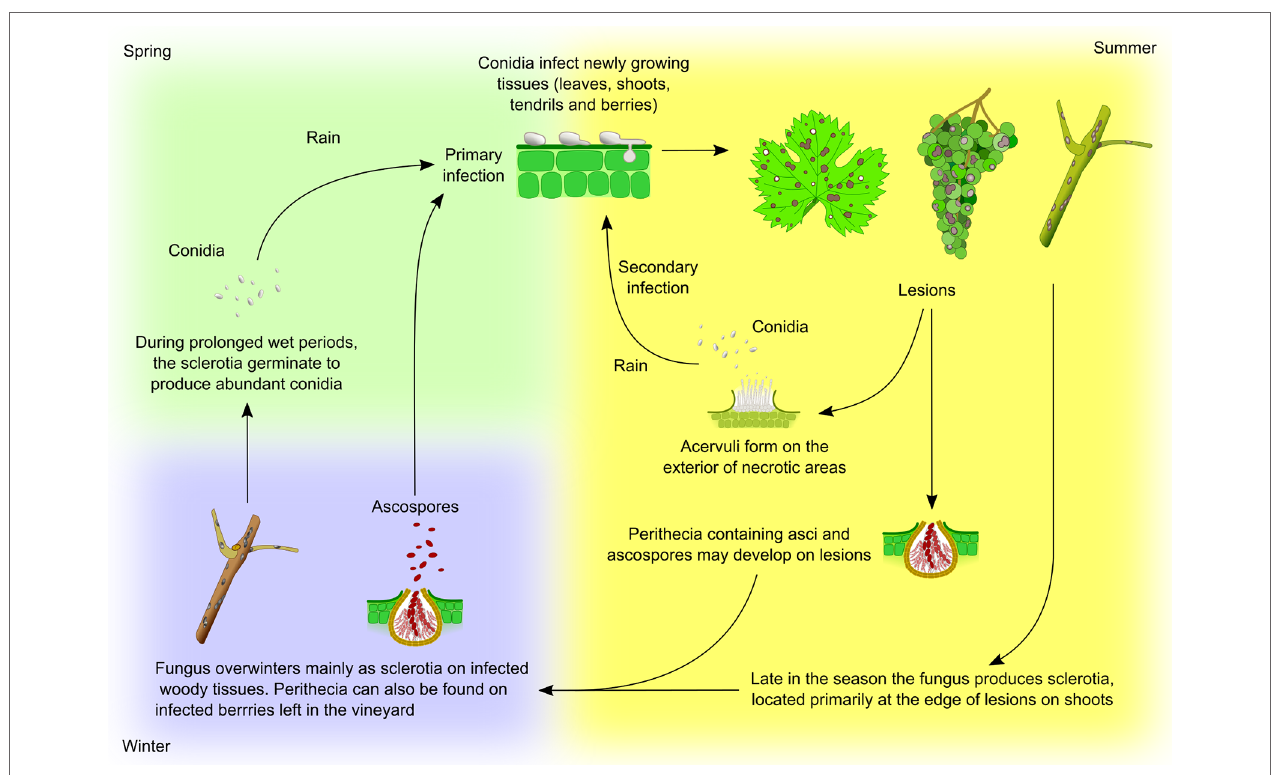
FIGURE 5 | Elsinoë ampelina life cycle. The fungus overwinters mainly in infected canes as sclerotia, dense mycelial masses which are formed in autumn at the edge of lesions on shoots. In spring, sclerotia develop stromata on which, under humid conditions, produce abundant conidia. These conidia are then carried by rain or free water to young, rapidly growing green tissues (leaves, shoots, tendrils and young berries) where they germinate causing the primary infection. Conidia are by far the most important source of primary inoculum in spring. The fungus can also overwinter on infected berries, left on the vine or vineyard floor, as conidia or ascospores, which may also cause primary infections. Once the disease is established, the pathogen produces lesions upon which acervuli form and produce conidia which, dispersed by raindrops, serve as secondary source of inoculum for the rest of the growing season. During periods of humid weather, conidia can be released the entire spring and summer providing continuous infection. Heavy rainfall and warm temperatures are ideal for disease development and spread. At times pseudothecia, containing asci and ascospores, develop on the lesions (Wilcox et al., 2017).